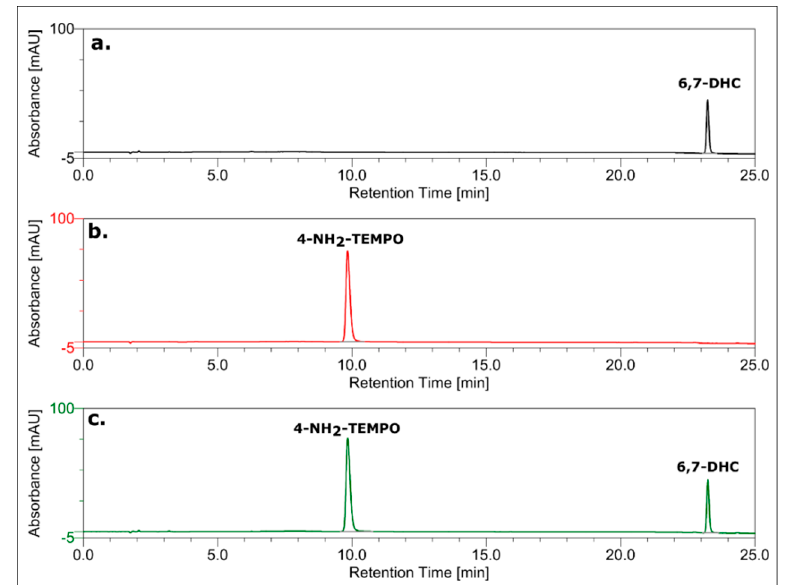
Figure 6. RP-HPLC chromatograms of: ( a ) 0.2 mM 6,7-dihydroxycoumarin; ( b ) 0.2 mM 4-amino-TEMPO; ( c ) the mixture of 0.2 mM 6,7-dihydroxycoumarin and 0.2 mM 4-amino-TEMPO. The chromatograms were recorded at 260 nm.